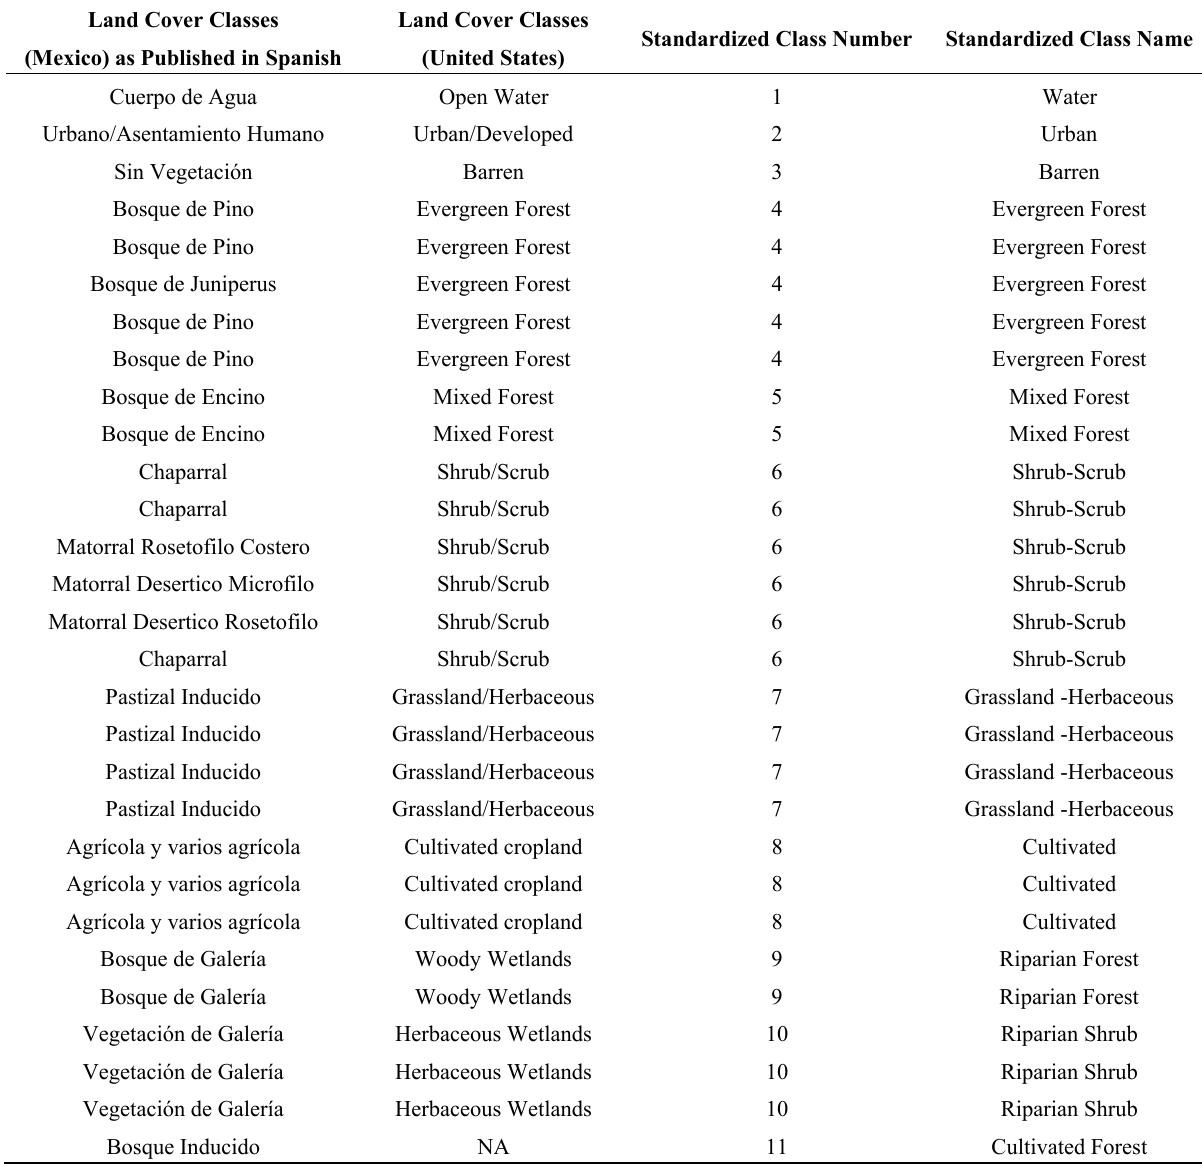
Table 2. Standardization of Land Use and Vegetation Cover (LUVC) categories names between